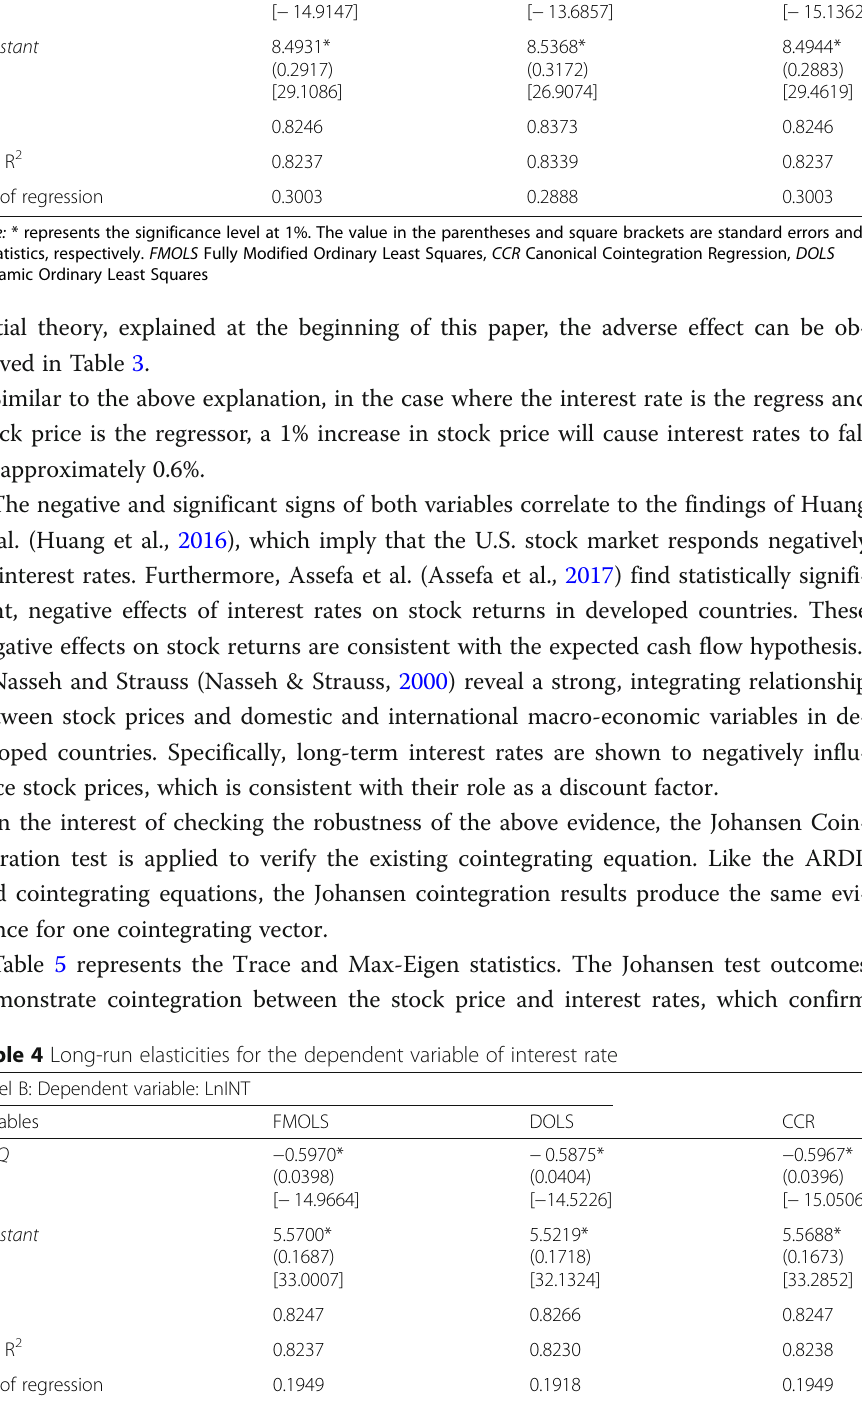
Table 3 Long-run elasticities for the dependent variable of stock price Panel A: Dependent variable: LnEQ Variables